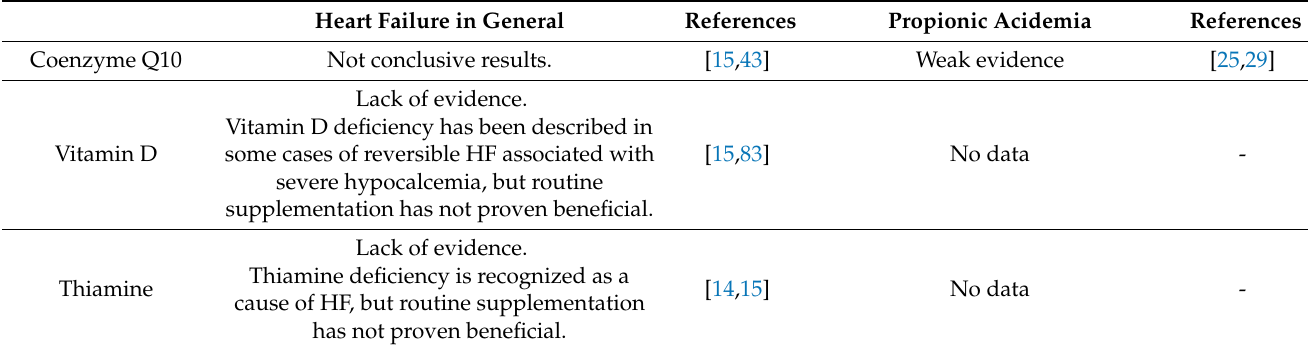
Table 2. Current micronutrient recommendations for patients with HF and for patients with PA. Heart Failure in